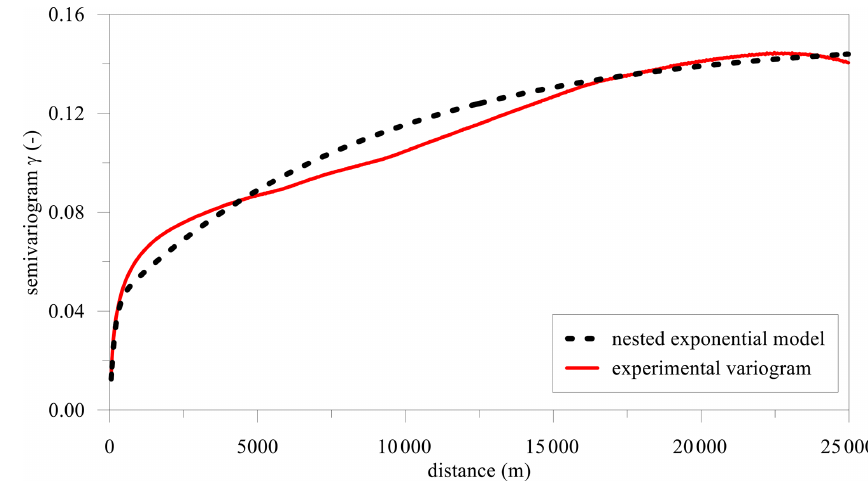
Figure A4. Semi-variogram of the predicted Sa 0 . 3 map (central Italy event that occurred on 30 October 2016): experimental variogram based on the adopted ML approach and best-fitting model (nested exponential).